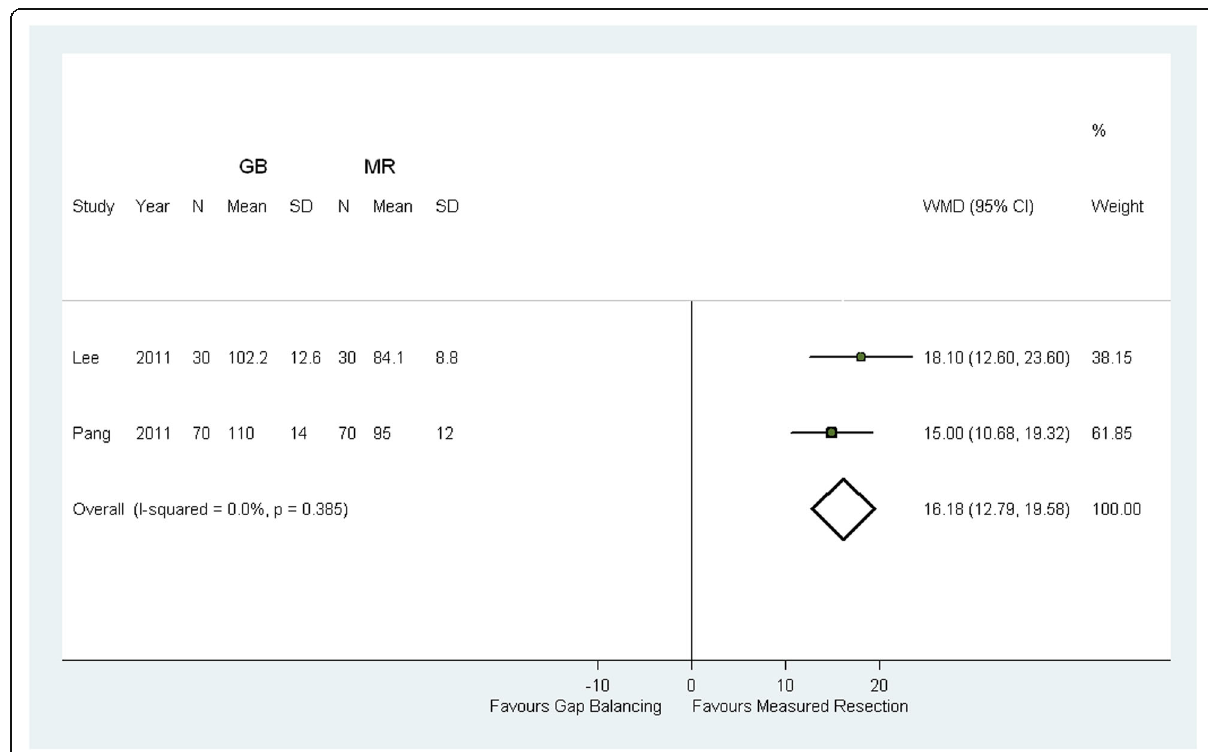
Fig. 4 Comparison of operative time between measured resection (MR) group and gap balancing (GB) group. SD = standard deviation, CI = confidence